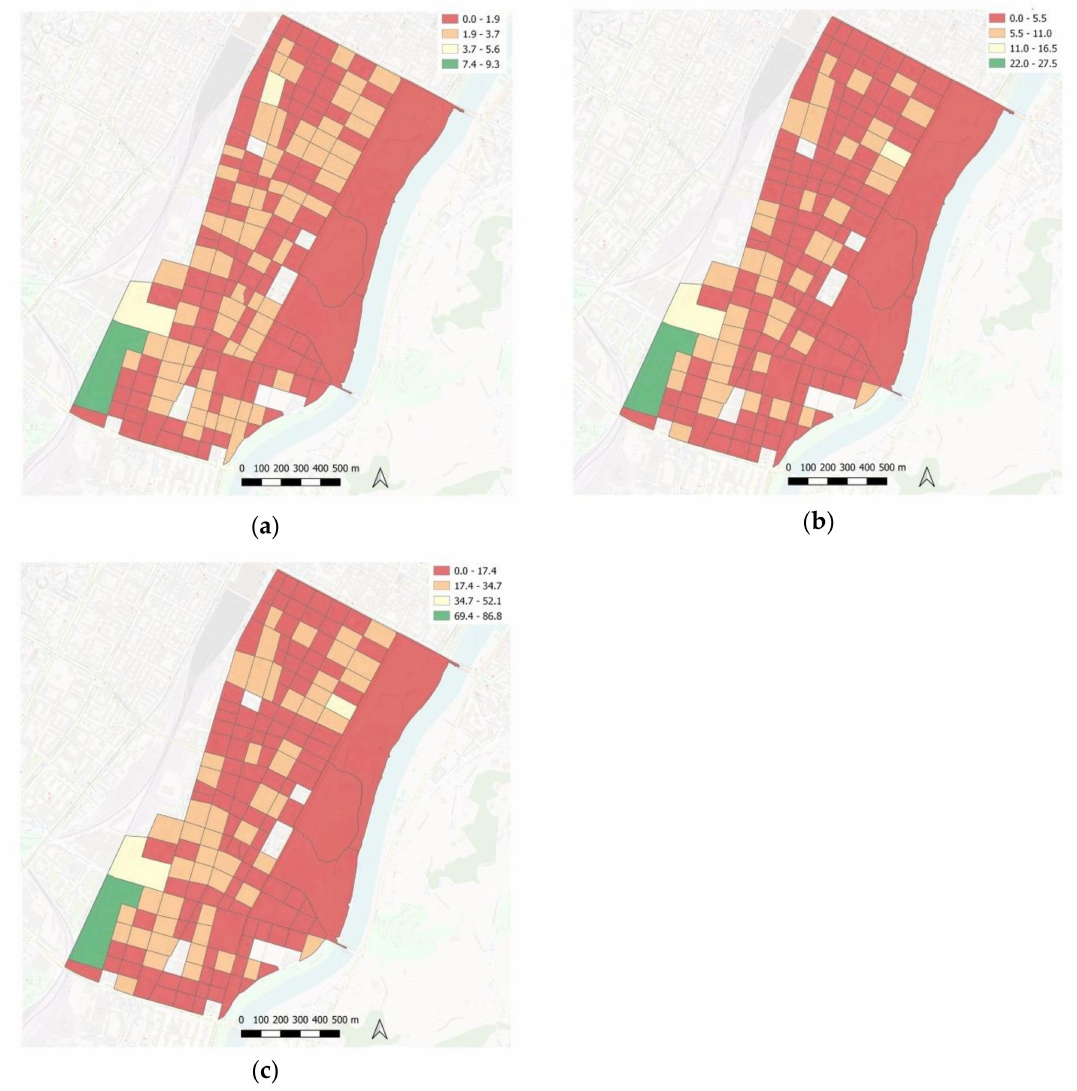
Figure 11. Variation of quantity in the adoption of PV over time for Scenario 0: ( a ) 2011, ( b ) 2019, ( c )